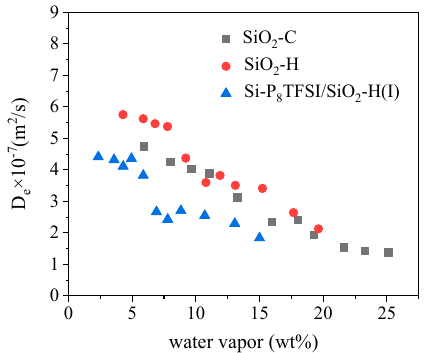
Figure 9. The curve of the e ff ective di ff usion coe ffi cients D e versus water vapor uptake.